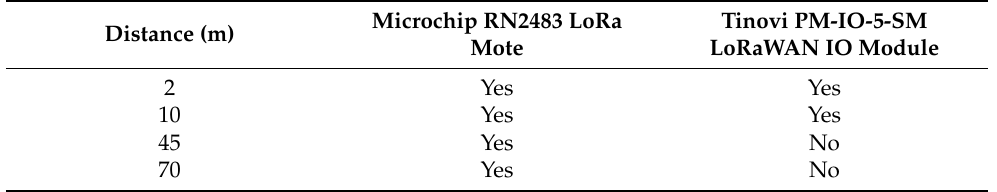
Table 3. End Devices transmission comparison.